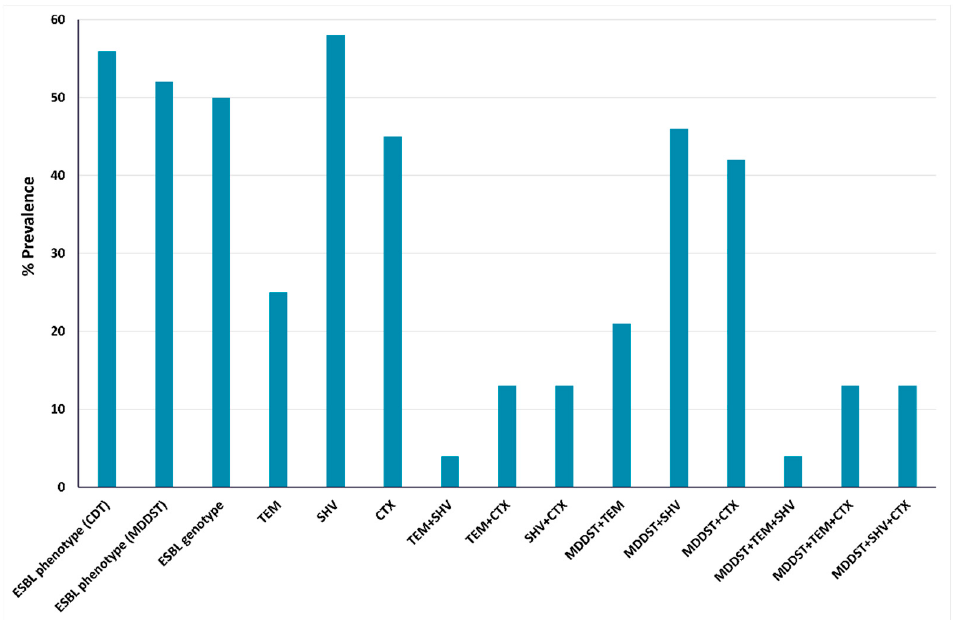
Figure 3. Phenotypic and genotypic compatibilities of ESBL production among 48 tested E. coli isolates.